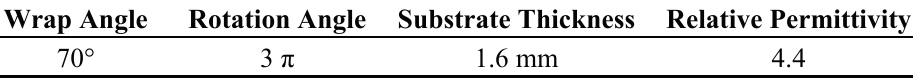
Table 1. Parameters of the designed